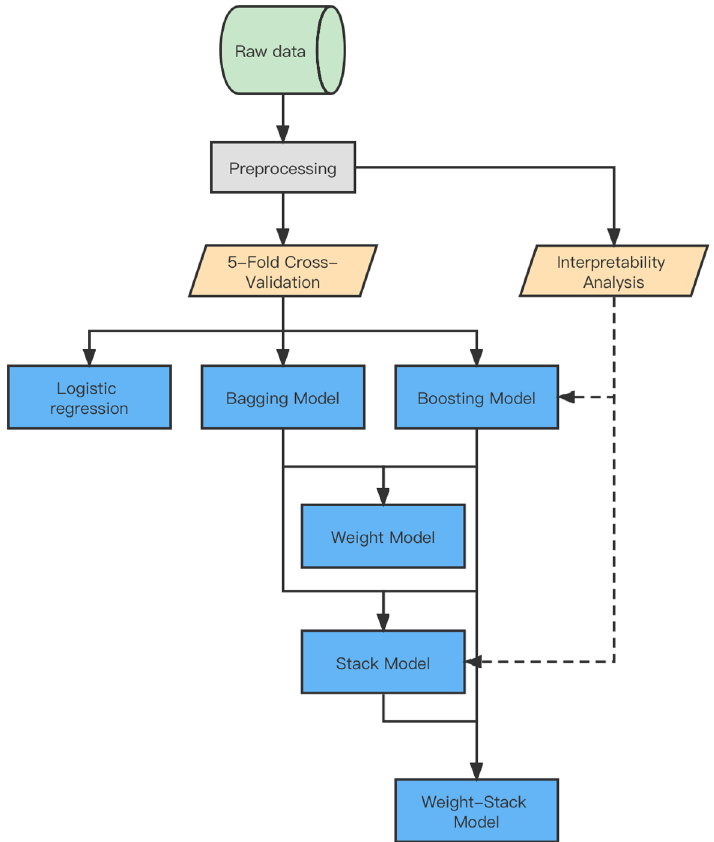
Figure 3. Overall workflow summarizing model